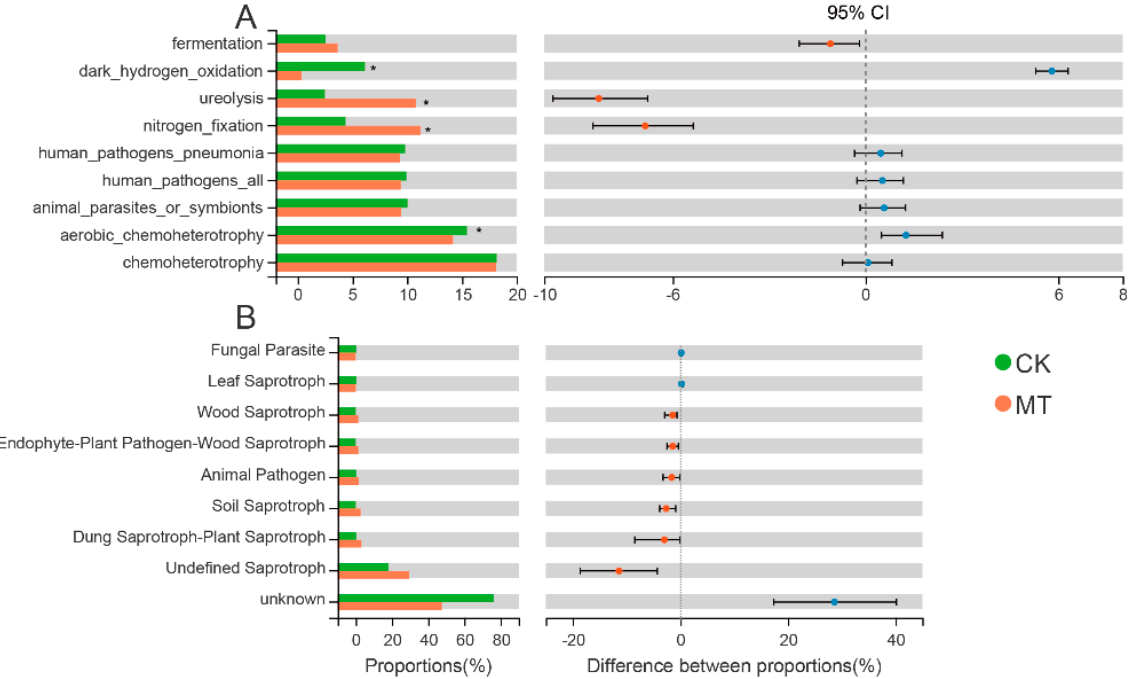
Figure 8. Wilcoxon rank-sum test bar plot. The relative abundances of potential bacterial ( A ) and fungal functional groups ( B ) under control (CK) and melatonin (MT) conditions in wastewater predicted by FARPROTAX and FUNGuild, respectively. “*” indicates significance at p < 0.05.